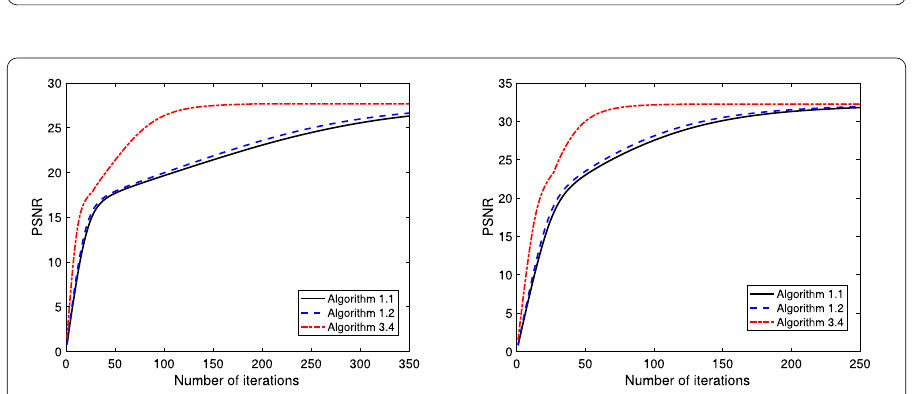
Figure 8 Graphs of PSNR value and number of iterations of Figs. 6 and 7,